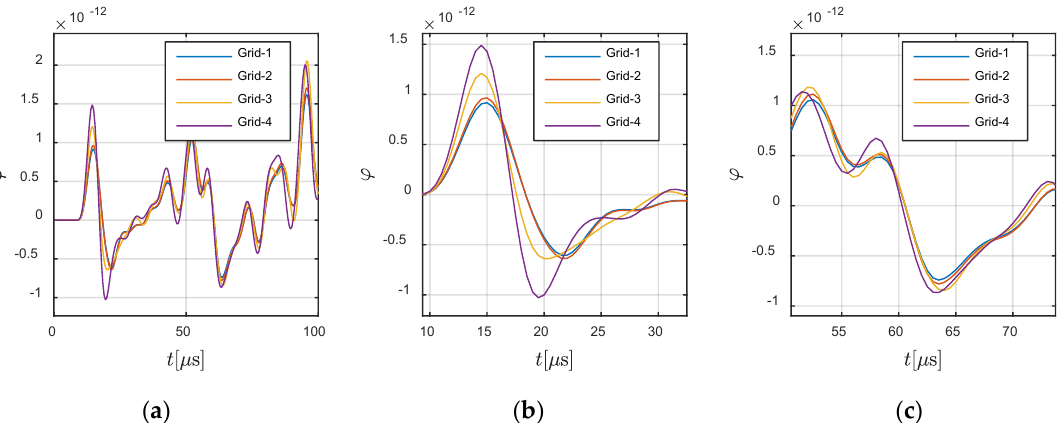
local views. The highlighted part defines the theoretical wavefront and duration of S-wave.